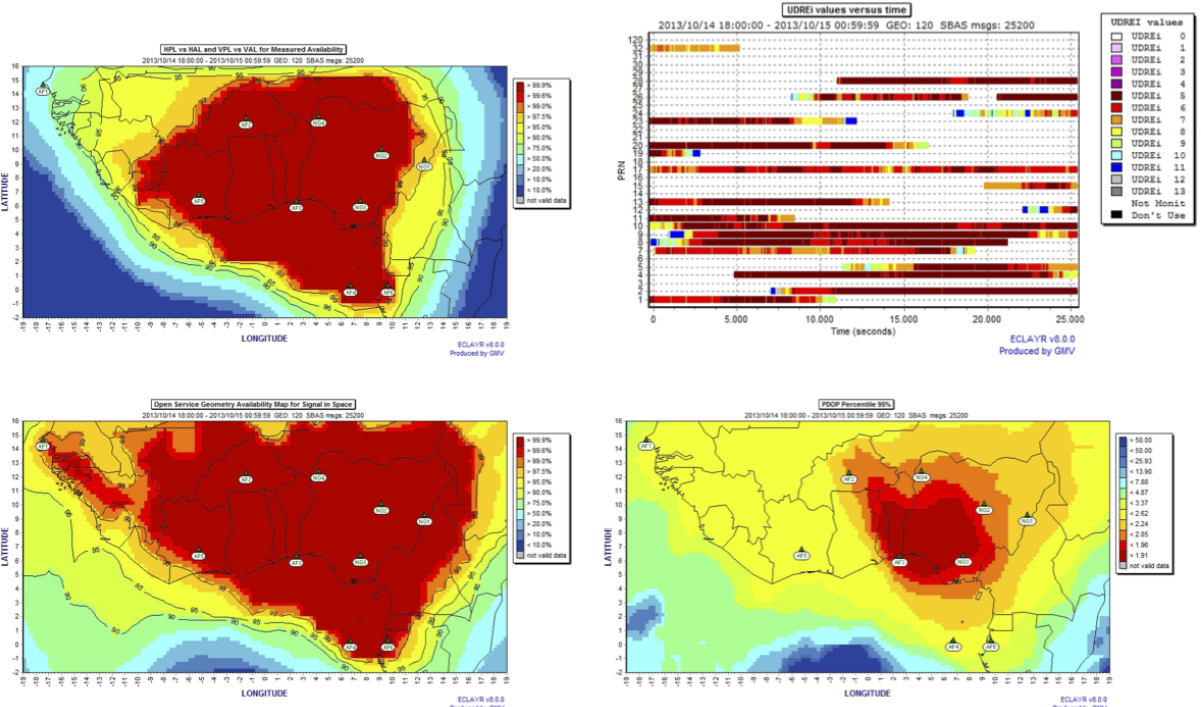
Figure 4. SBAS APV-1 availability map (upper left panel), user differential range error (UDREi) (upper right panel), open service geometry availability map for signal in space (lower left panel) and positional dilution of precision (lower right panel) for 14 October 2013 when irregularities were